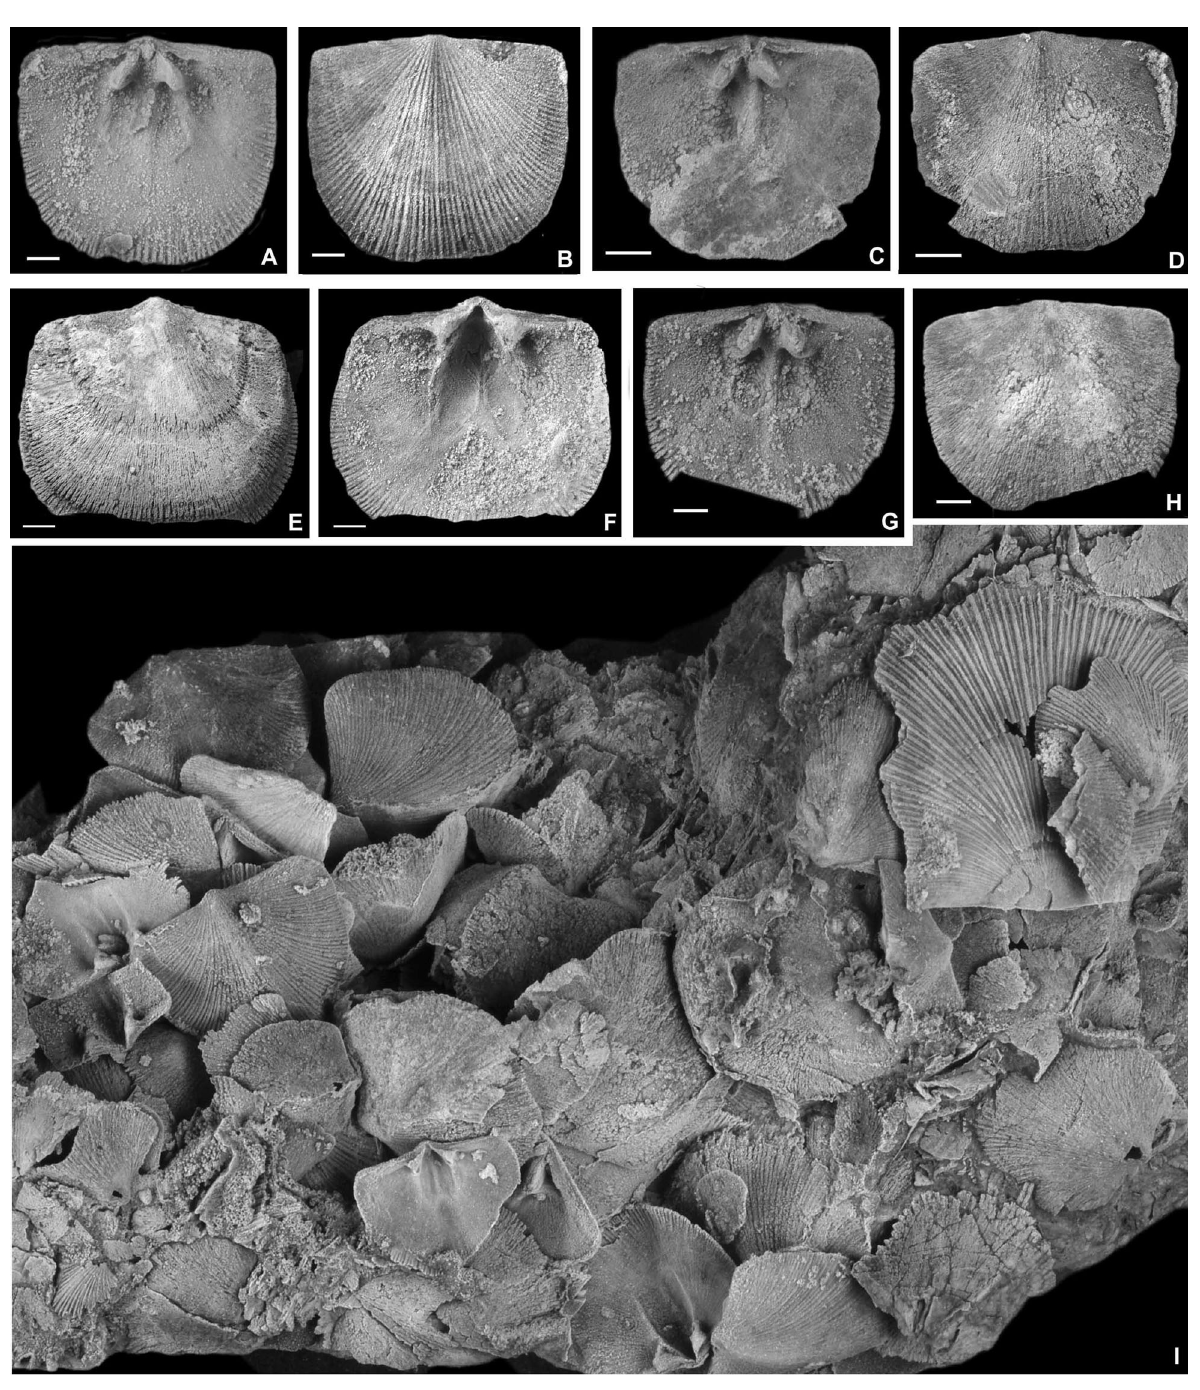
Fig. 4. Isorthis ( Ovalella ) inflata sp. nov.; Llandovery, mid-late Aeronian, Niur Formation, sample S14, Derenjal Mountains. A , B , NMW 2011.11G.91, holotype, dorsal valve interior, exterior; C , D , NMW 2011.11G.92, dorsal valve interior, exterior; E , F , NMW 2011.11G.28, ventral valve exterior, interior; G , H , NMW 2011.11G.90, dorsal valve interior, exterior; I , NMW 2011.11G.193, slightly dissolved surface of a shell bed showing accumulation of disarticulated valves of Isorthis ( Ovalella ) inflata sp. nov. All scale bars 2